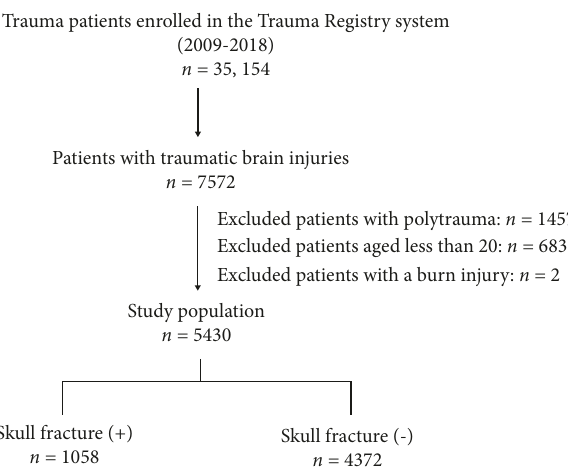
Figure 1: Flowchart illustrating the enrollment of the adult patients with traumatic brain injuries in this